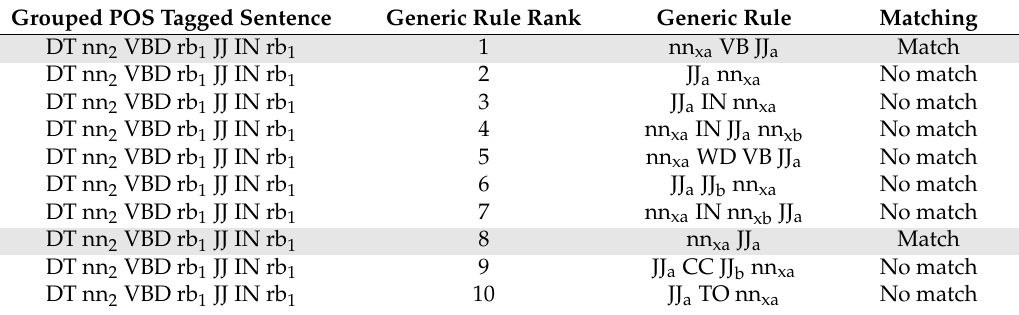
Table 11. Matching of grouped POS tagged sentence with generic